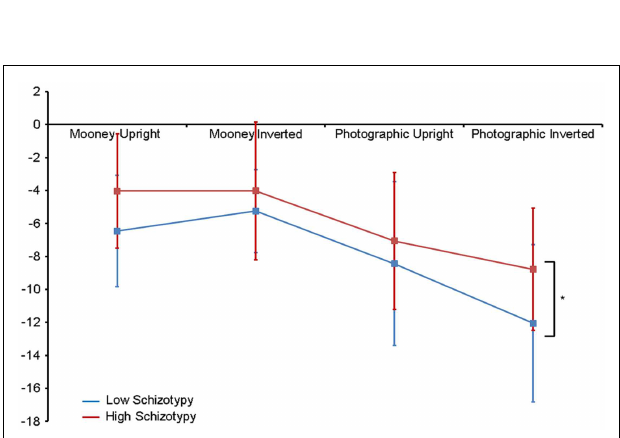
FIGURE 3 | N170 latency group × orientation interaction effect . Comparable peak latencies are shown to upright stimuli by both groups, however, high schizotypes show earlier peak latencies to inverted face stimuli (most difficult to perceive).